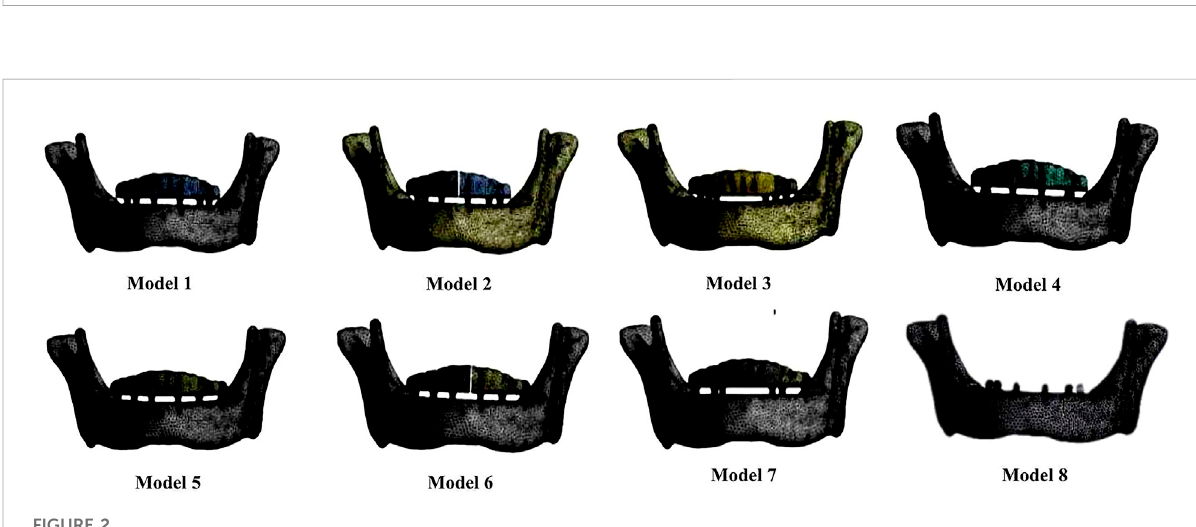
FIGURE 2 Model meshing and